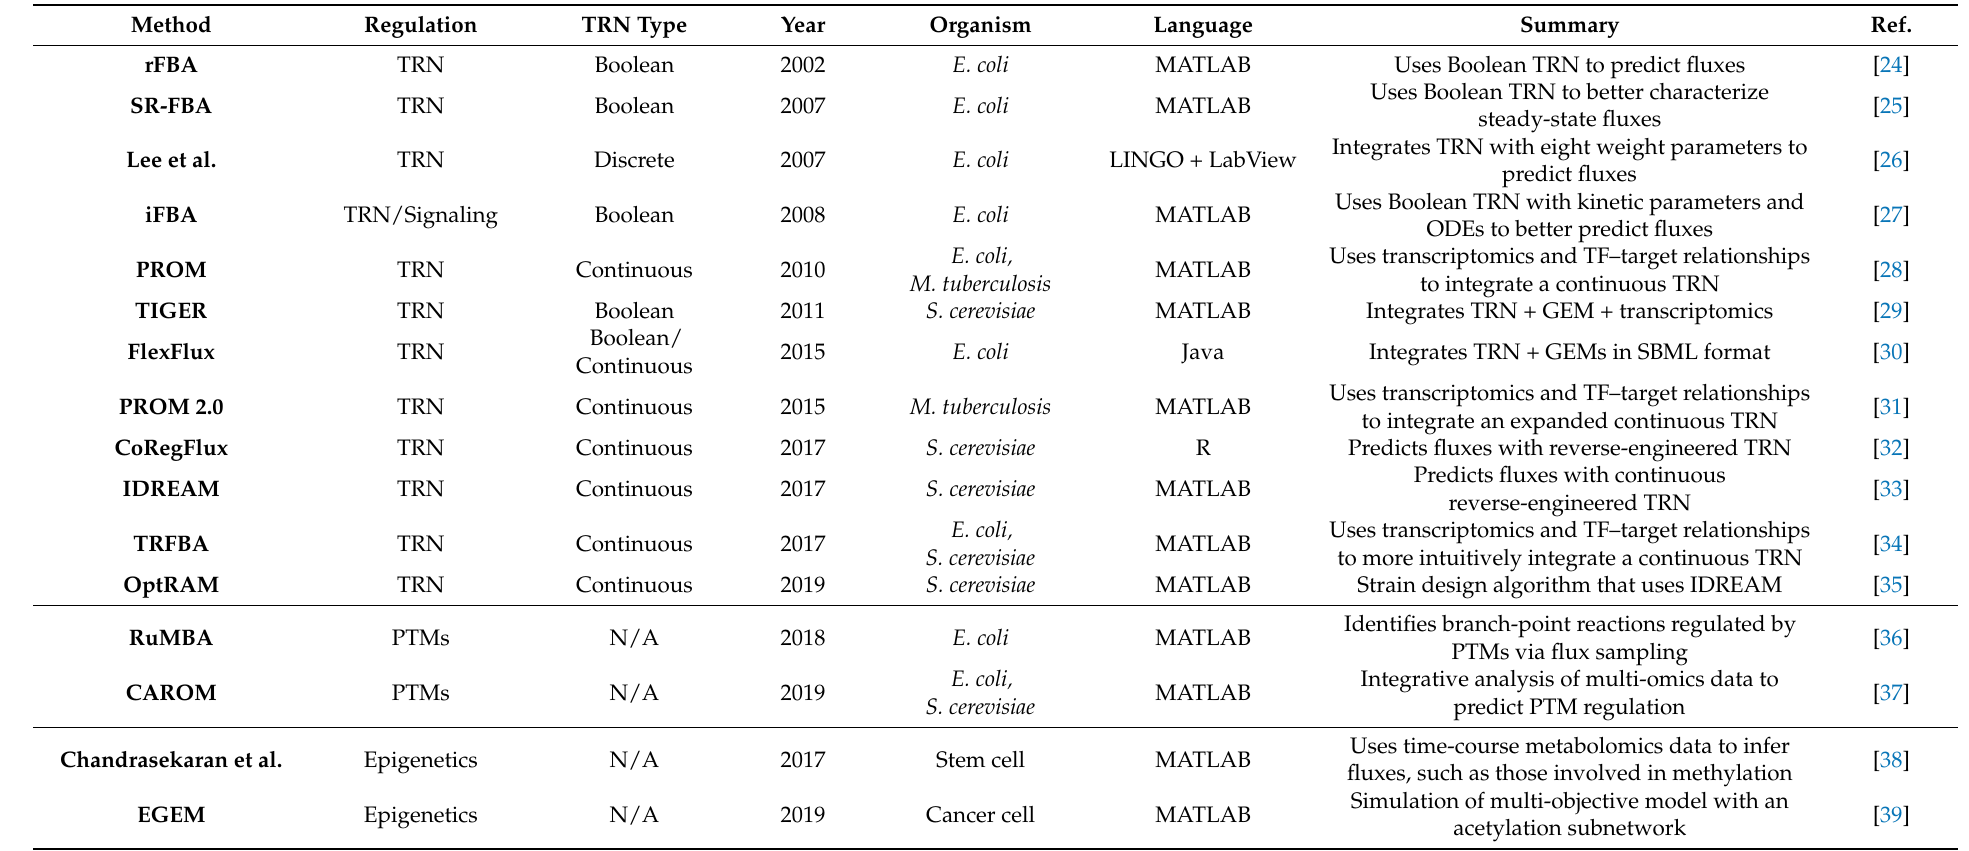
Table 1. 22 methods (bolded) integrating regulatory mechanisms into genome-scale metabolic models (GEMs). N/A: not applicable. Abbreviations: rFBA -regulatory flux balance